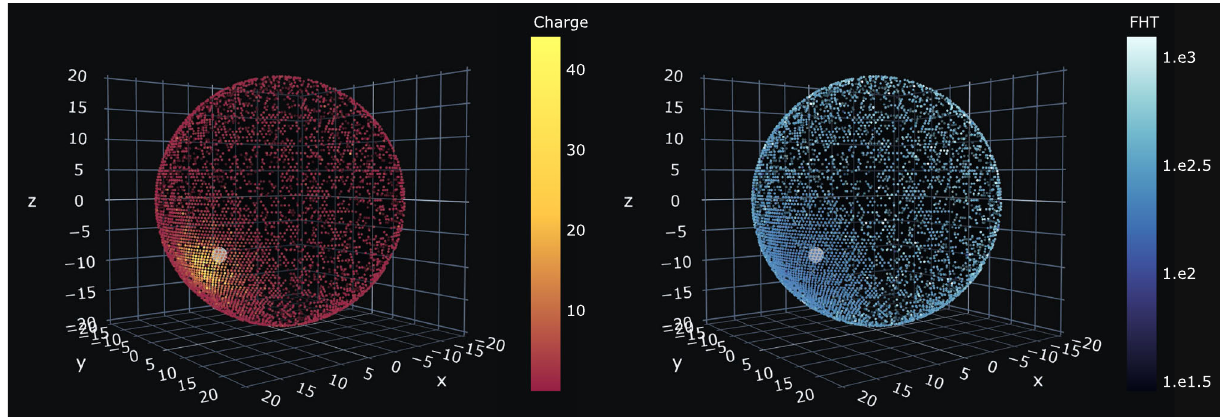
Fig. 2 Example of a positron event with the deposited energy of 6.165 MeV as seen by 20-inch PMTs. Only fired PMTs are shown. On the left, the color represents the accumulated charge: yellow points show the channels with more hits, red points show the channels with